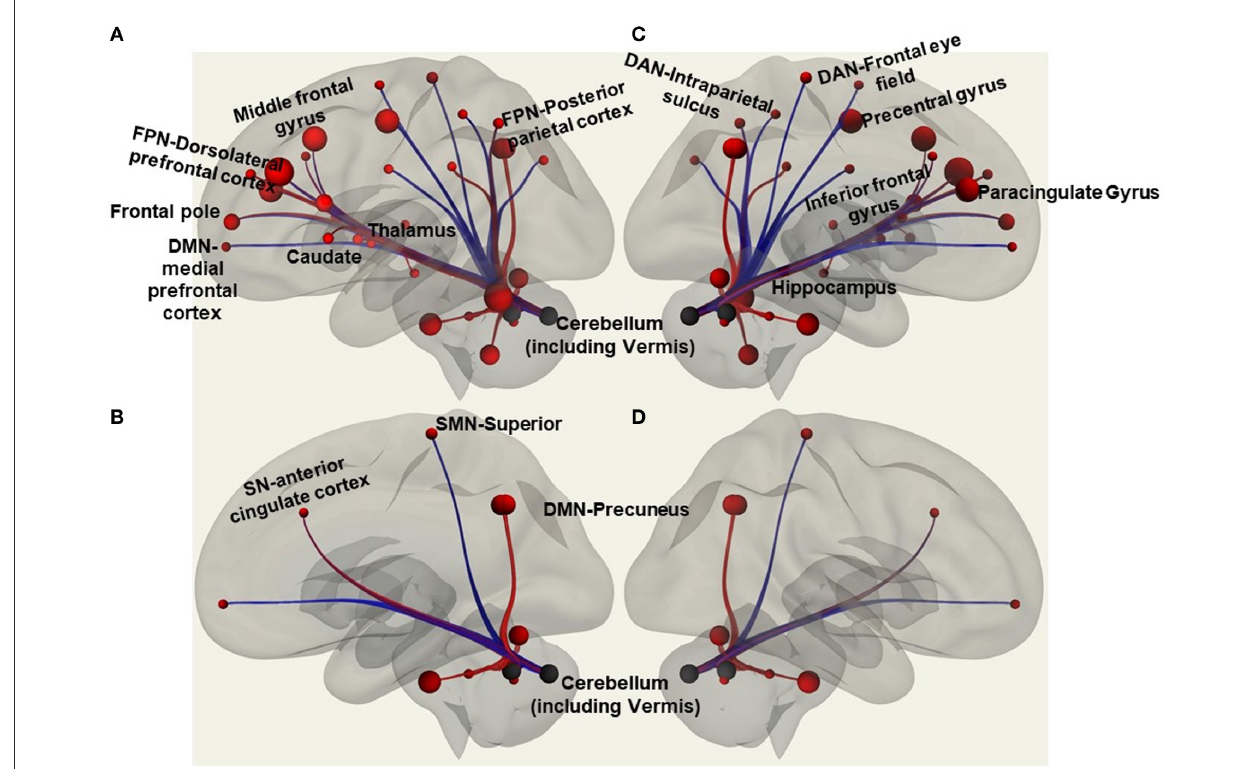
FIGURE1 Regions of interest in the CONN software included functional connectivity analyses of atlas-atlas, altas-network, and network-network associations with red lines to indicate increased functional connectivity strength and blue lines to show decreased functional connectivity strength. The figure is a representation of some of those regions with (A) showing atlas regions involving frontal pole, middle frontal gyrus, caudate, thalamus, cerebellum; and network regions like frontoparietal network (FPN) that includes dorsolateral prefrontal cortex and posterior parietal cortex. (B) Shows atlas region involving the cerebellum; and anterior cingulate cortex of salience network (SN), superior of sensorimotor network (SMN), and precuneus of default mode network (DMN). (C) Shows inferior frontal gyrus, precentral gyrus, paracingulate gyrus, cerebellum and vermis, hippocampus; and frontal eye field, and intraparietal sulcus of dorsal attention network (DAN). (D) Shows precuneus of DMN and the cerebellum and